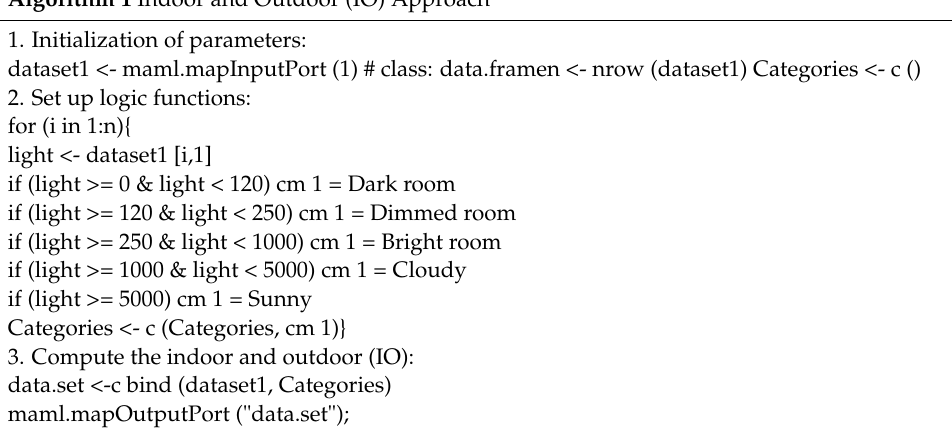
Algorithm 1 Indoor and Outdoor (IO)